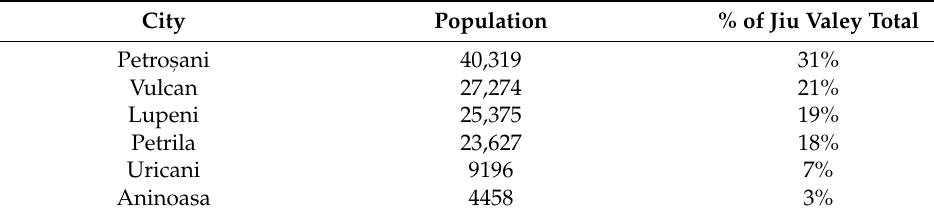
Table 1. The distribution of the population from the Jiu Valley (2021).